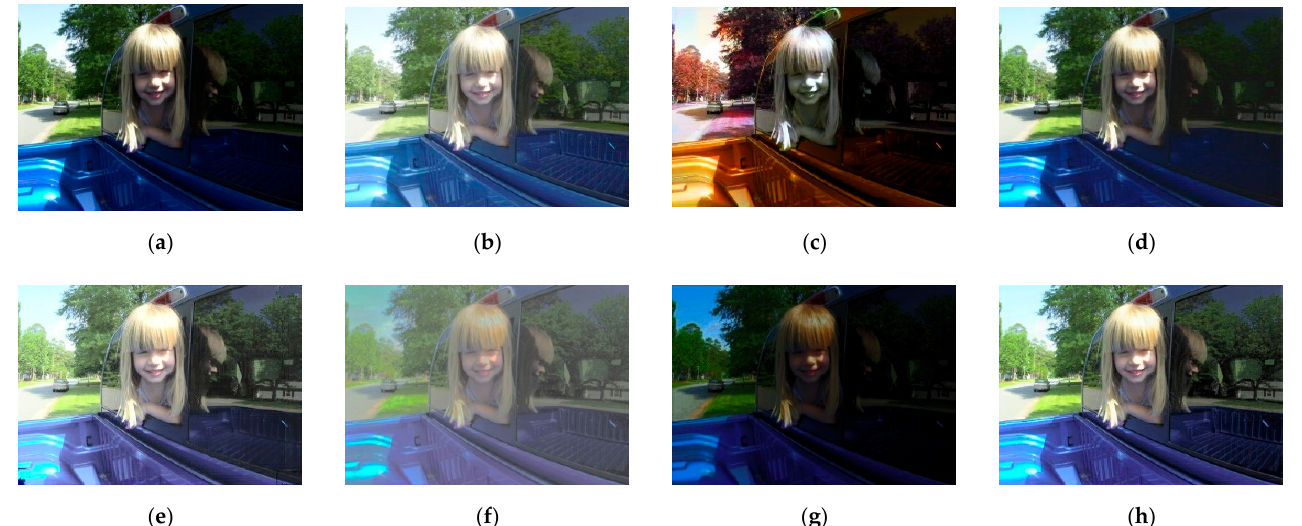
Figure 15. Bright surrounding image #1: ( a ) input, ( b ) target, ( c ) CycleGAN, ( d ) Lum CycleGAN, ( e ) EV GAN, ( f ) HDRCNN, ( g ) ExpandNet, and ( h ) the proposed model.